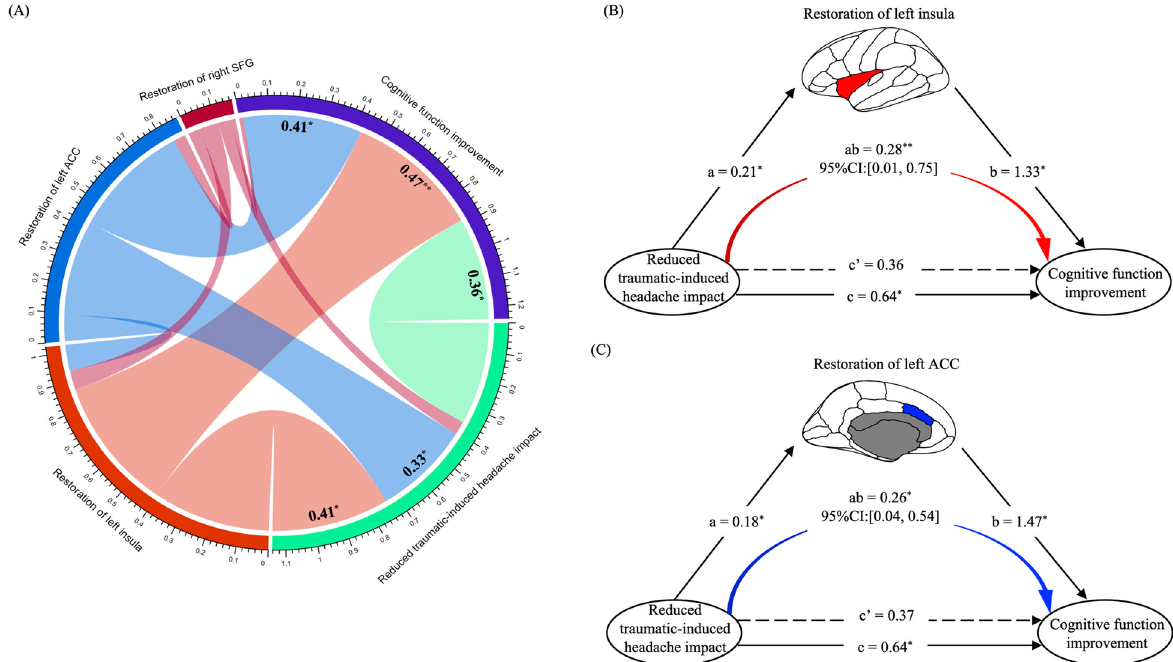
Fig. 4 Relationships between the neuroanatomical restoration of hub nodes in salience network, reduced traumatic-induced headache impact and cognitive function improvement in patients. A Cognitive function improvement was significantly correlated with restoration of left insula, left ACC, and reduced headache impact; the reduced headache impact was significantly correlated with restoration of left insula, and left ACC. Black numbers represent positive effects. Both the restoration of B left insula and C left ACC mediated the relationship between reduced headache impact and cognitive function improvement, respectively. MTBI, mild traumatic brain injury; PTH, posttraumatic headache; ACC, anterior cingulate cortex; SFG, superior frontal gyrus; 95% CI, 95% confidence interval; * , P < 0.05;. ** , P <